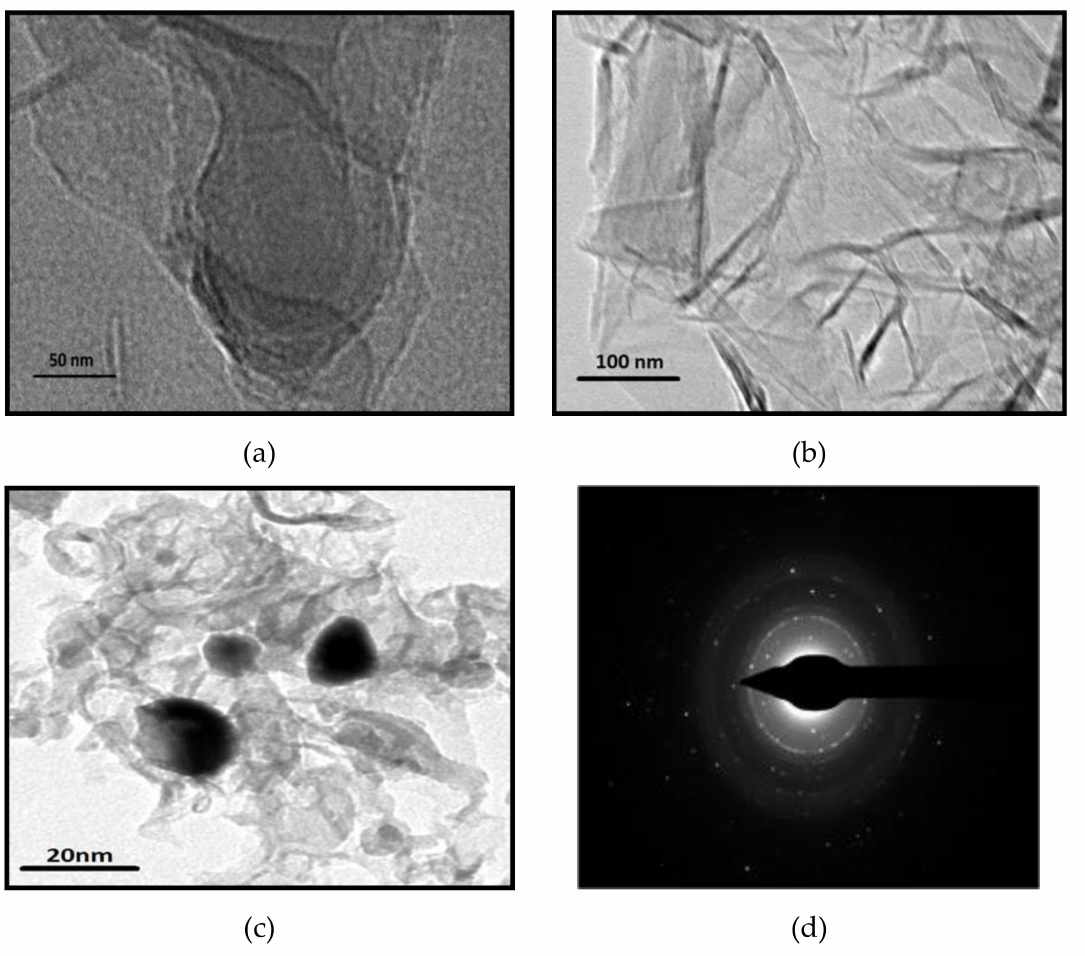
Figure 2. Transmission electron microscopy (TEM) images: ( a ) HRGO, ( b ) SG, ( c ) MSG samples, and ( d ) the selected area electron di ff raction (SAED) pattern of MSG